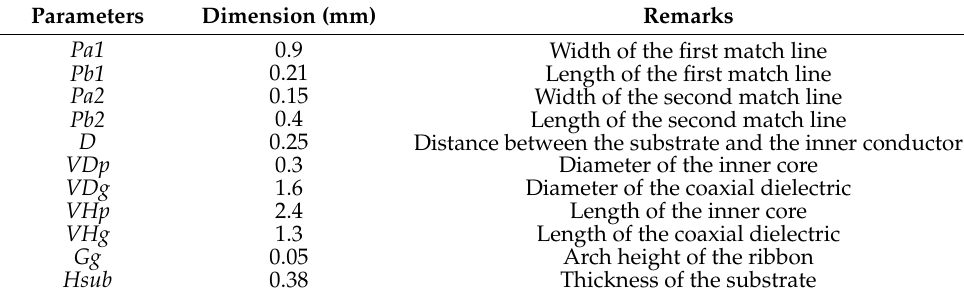
Table 5. Parameters of the matching structure in the vertical interconnection.